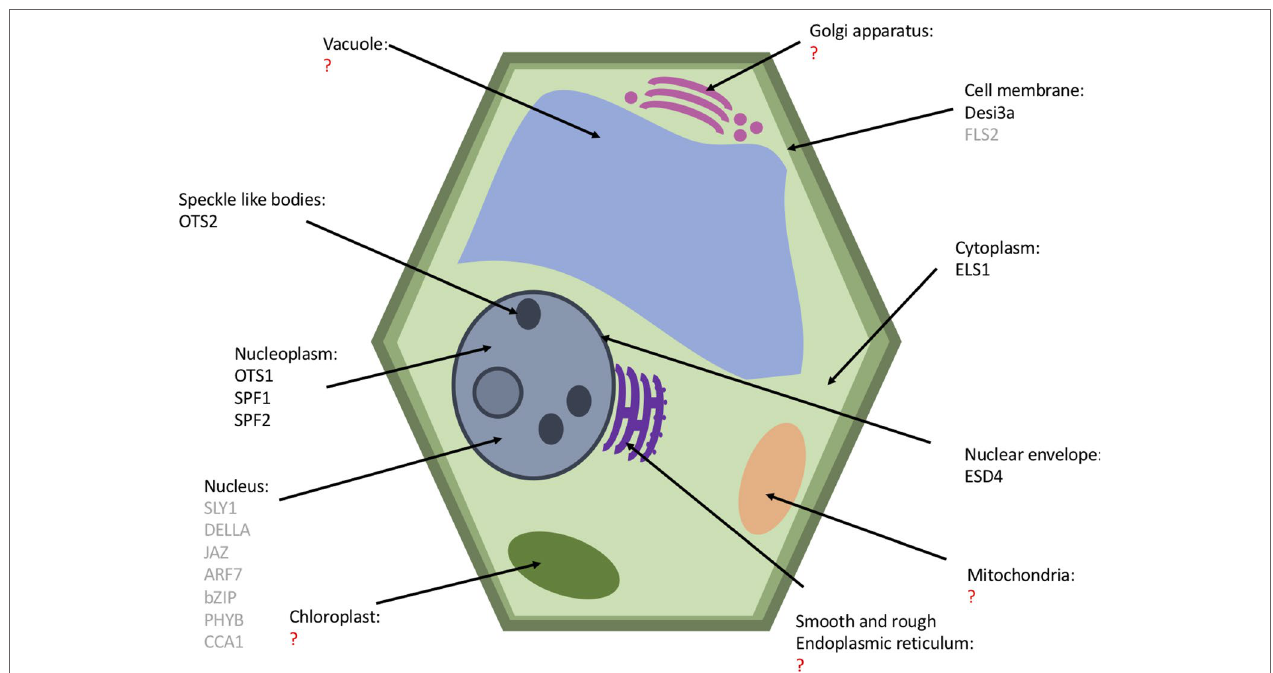
FIGURE 6 | A plant cell featuring the known cellular location of SUMO proteases (black) and their substrates (gray). Organelles with a question mark (red) have no known SUMO proteases or substrates but may have undiscovered SUMO